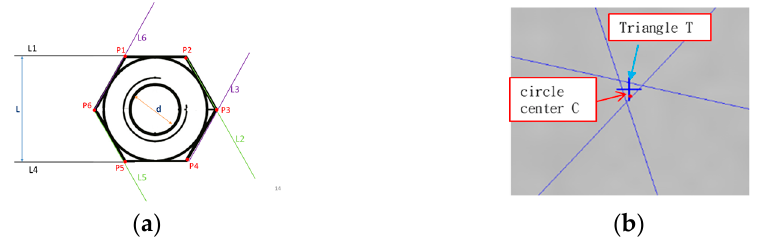
Figure 2. De fi ning the information: ( a ) code name; ( b ) center code name.